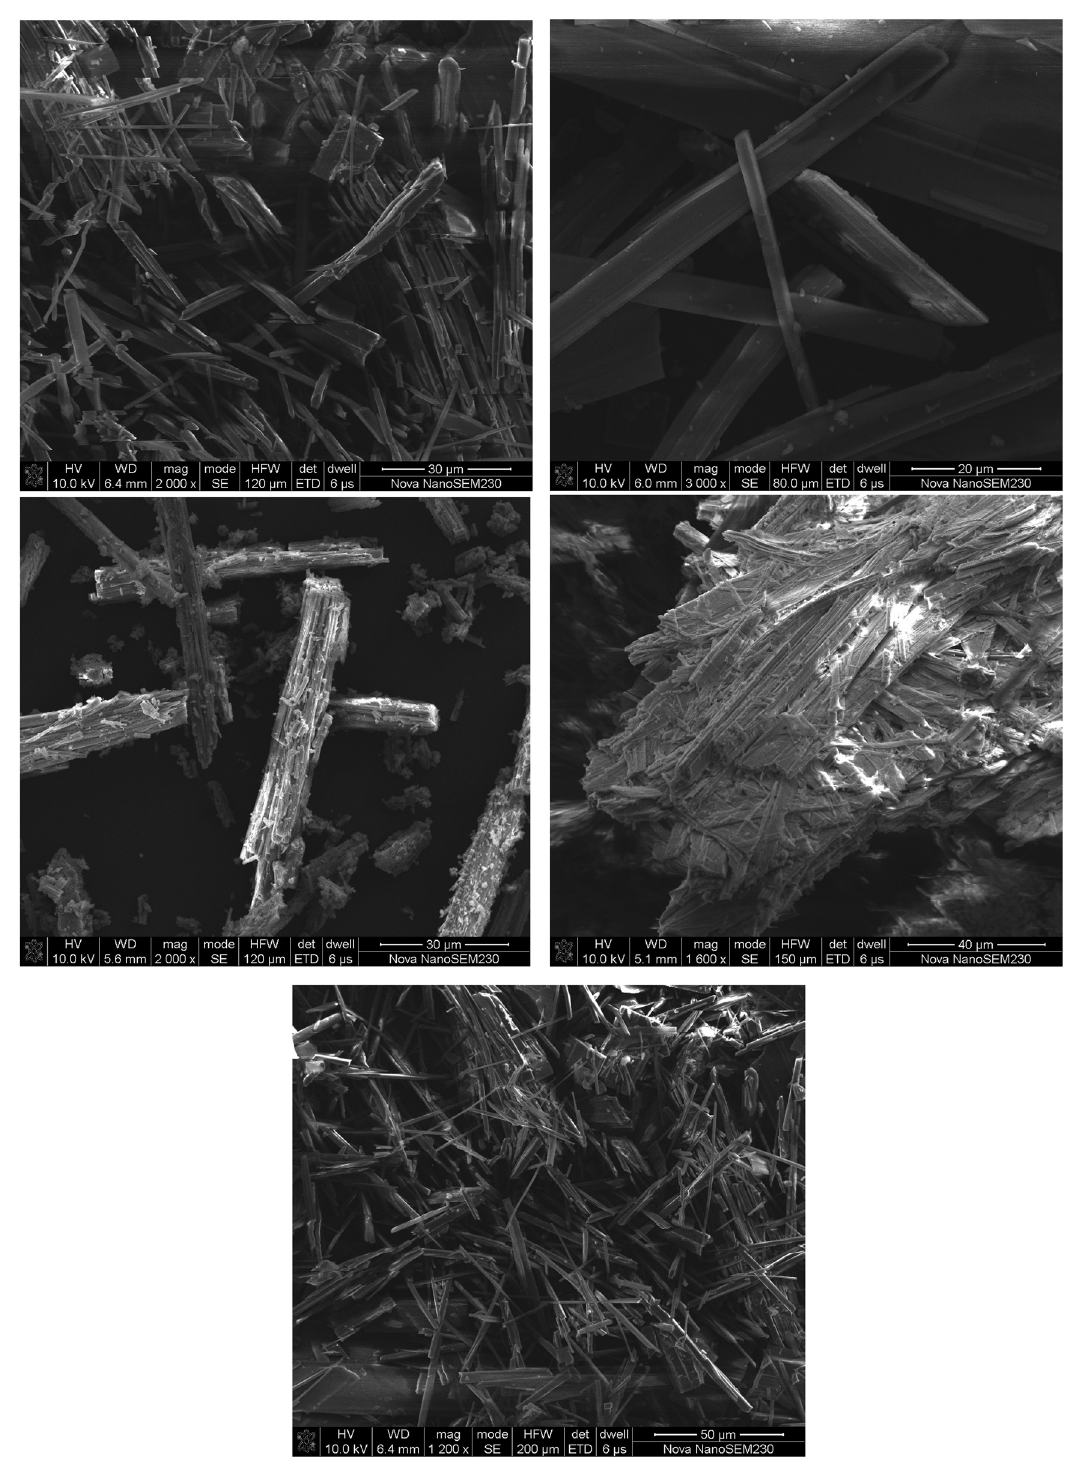
Figure 4: SEM of Zn -